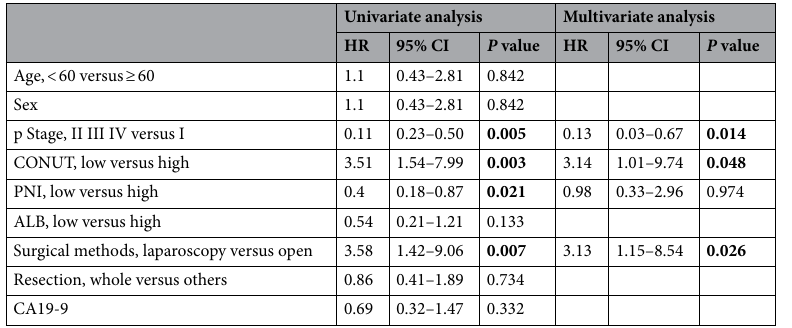
Table 13. Univariate and multivariate analyses of independent risk factors for postoperative global QoL.